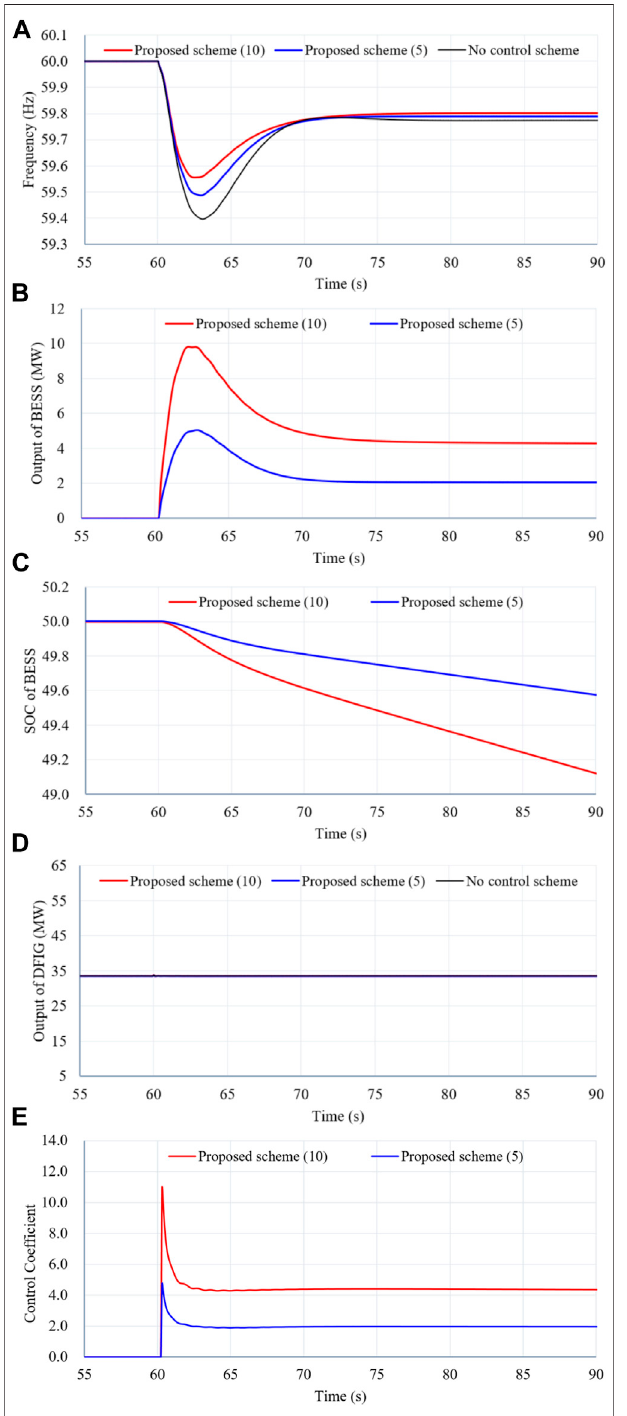
FIGURE 10 | Results for Case 2. (A) System frequency. (B) Output power of the BESS. (C) SOC of the BESS. (D) Output power of the DFIG. (E) Control coef fi cient.